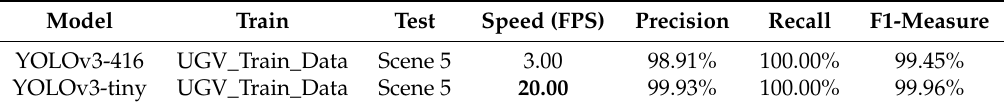
Table 6. The YOLOv3-416 compared to YOLOv3-tiny in NVIDIA Jetson TX2.